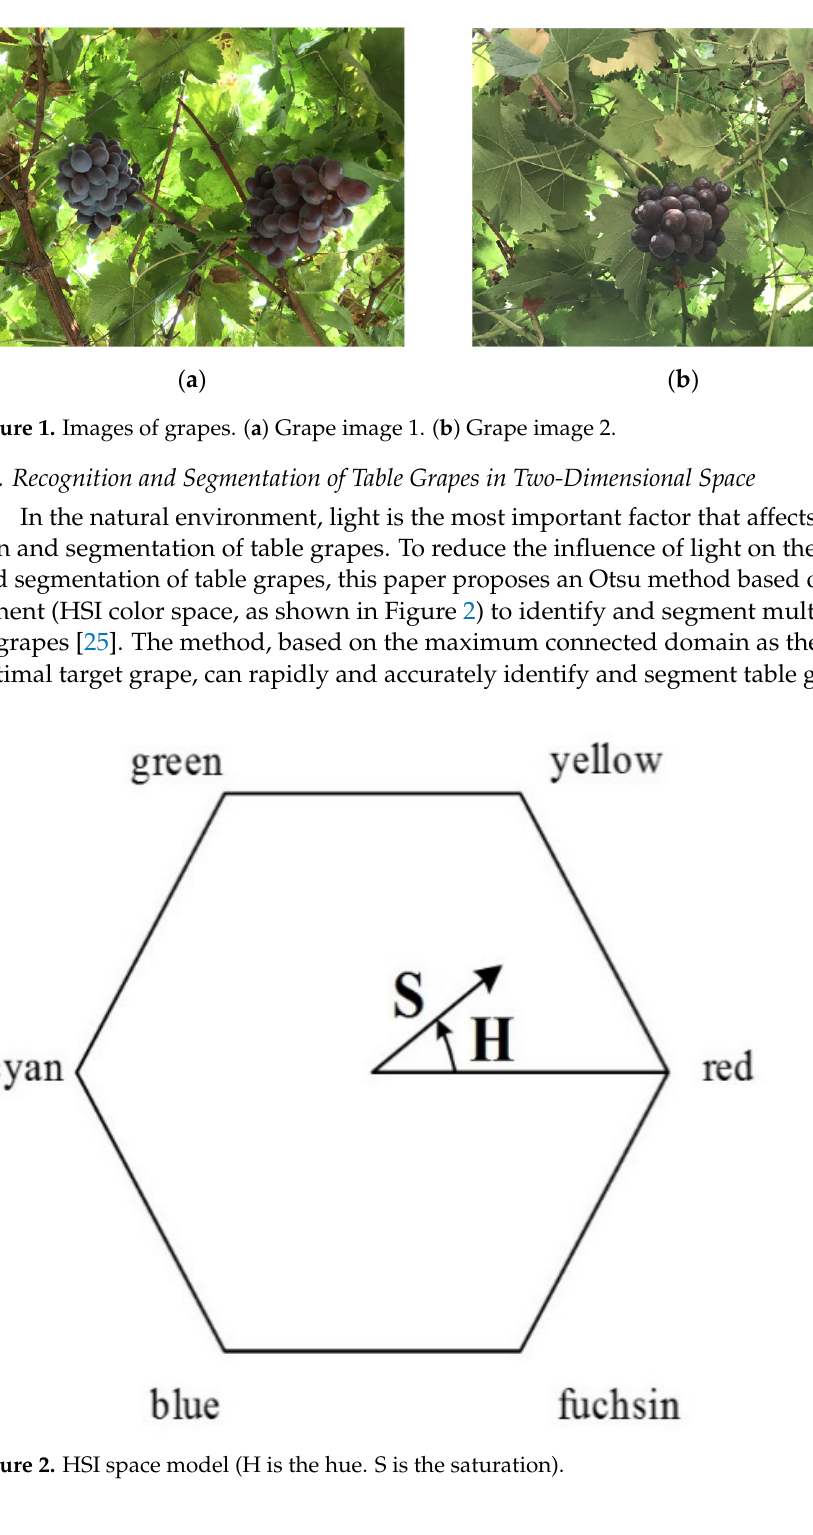
Figure 2. HSI space model (H is the hue. S is the saturation).